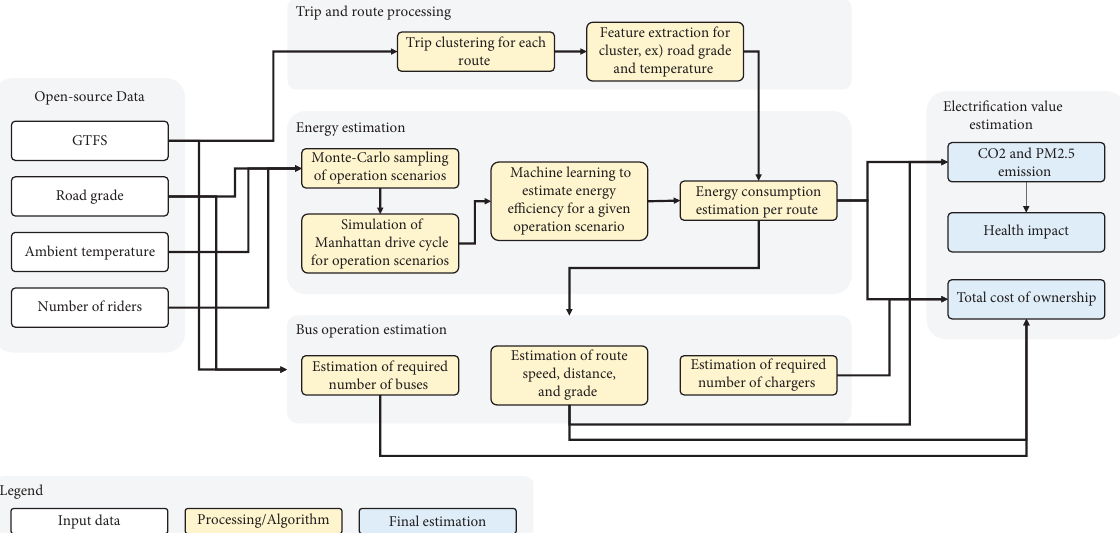
Figure 2: Framework of proposed valuation method.